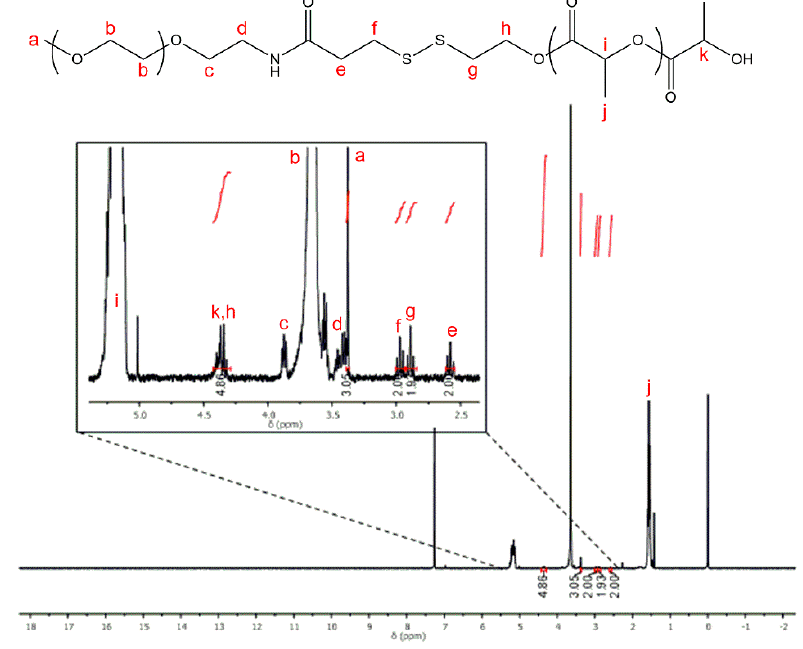
Figure 5. 1 H NMR spectrum of P2 copolymer (step 3, CDCl 3 , 25 °C).